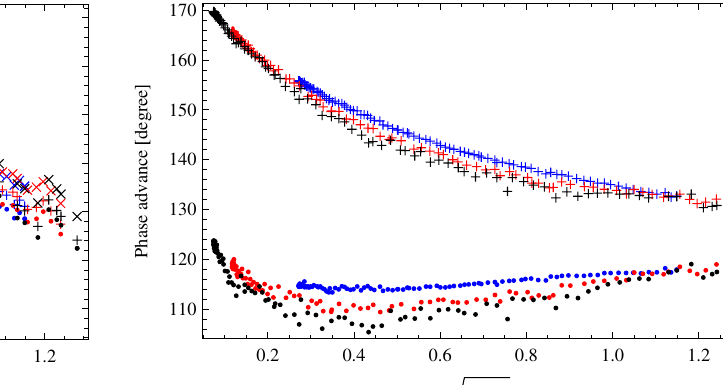
FIG. 8. Phase advances within an optimal dipole for AME ( (cid:2) ), TME ( þ ), and EME ( (cid:7) ) under 2 (blue), 4 (red), and 6 (black) times higher peak field. The corresponding phase advances for the reference uniform dipole are 157 (cid:6) , 151 (cid:6) , and 150 (cid:6) , respectively.